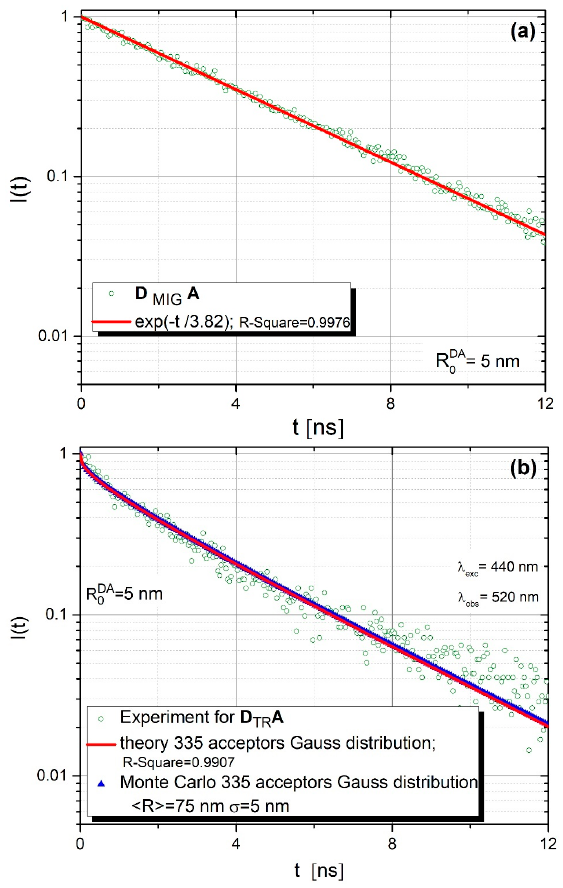
Figure 5. Donor fluorescence intensity decays for ( a ) D MIG A and ( b ) D TR A systems, bonded cova- lently to the core-shell surface.